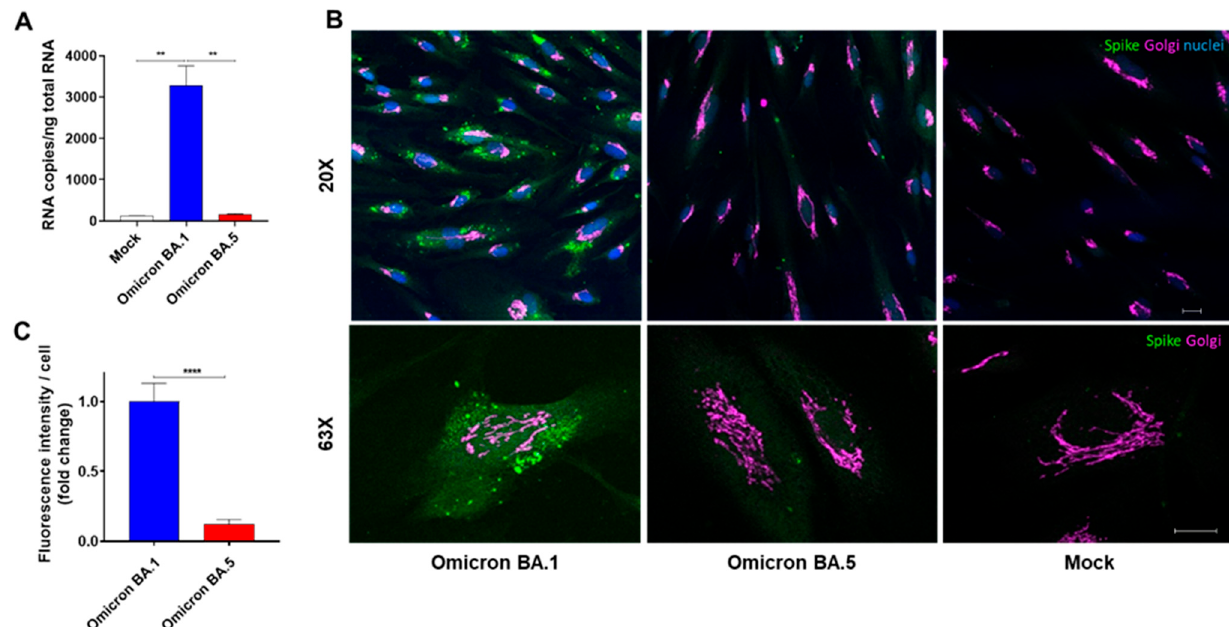
Figure 3. Omicron BA.5 does not infect HL-mECs. HL-mECs were mock-infected (Mock) or infected with Omicron SARS-CoV-2 belonging to BA.1 or BA.5 sublineages (Omicron BA.1 and Omicron BA.5, respectively) at an MOI of 1 for 1 h at 37 °C, then washed and cultured until day 1 p.i. ( A ) The graph shows the quantitation of SARS-CoV-2 genomes at the intracellular level by qRT-PCR. At least three replicates were performed. Data are representative of two independent experiments with similar results. Statistical analysis was performed by one-way ANOVA (** p < 0.01). ( B ) HL-mECs were fixed with 4% PFA in PBS, permeabilized with 0.1% Triton X-100 in PBS, and saturated with 0.1% BSA, 0.1% Tween 20 in PBS. For staining, cells were incubated for 1 h with a human serum containing IgG to SARS-CoV-2 and anti-GM130 antibody as cis-Golgi marker followed by Alexa Fluor 488-conjugated anti-human IgG or Alexa Fluor 647-conjugated anti-rabbit IgG. Nuclei were counterstained with DAPI (scale bar, 20 µm). Images display SARS-CoV-2 signals in green and cell nuclei in blue. ( C ) The Spike-related fluorescent area was quantified in 20–30 Omicron BA.1- and Omicron BA.5-infected cells and subtracted of mock cells fluorescence signal. The decrease of Spike-related fluorescence in Omicron BA.5 cells was related to Omicron BA.1 signal and was expressed as fold change. Statistical analysis was performed by unpaired t -test (**** p <